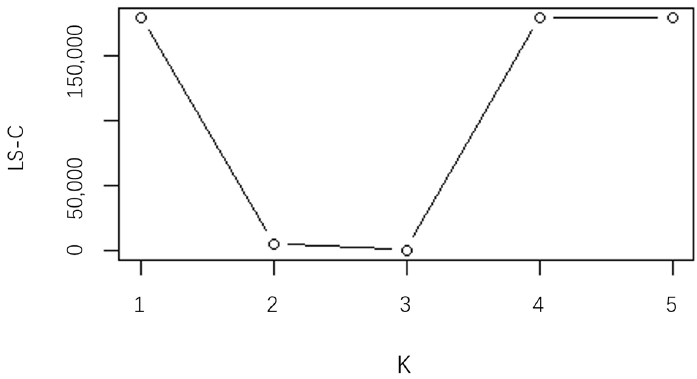
Figure 1. LS-C values over the candidate K for the simulation data.